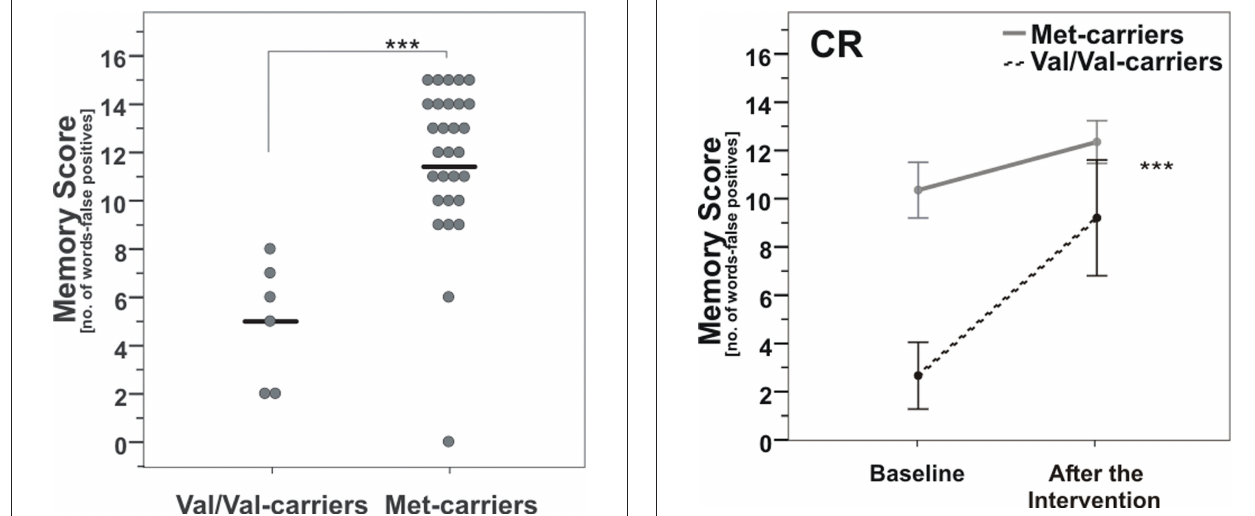
Figure 3 | Memory scores according to COMT Val 158 Met genotype pre- vs. post-caloric restriction (Cr) . Note that Val/Val -carriers (dashed line) nearly reached baseline levels of carriers of at least one Met -allele (gray line) after CR. ***, p = 0.001; ***, according to ANOVA . Error bars indicate RM standard error (SE).